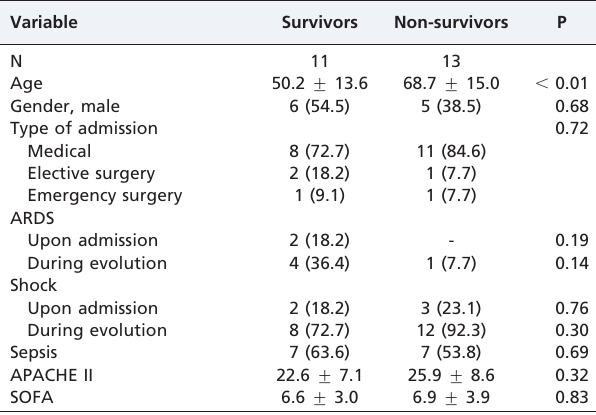
Table 3 - Comparison of surviving and non-surviving CCI